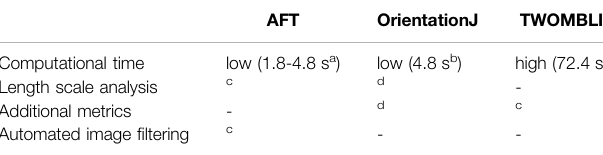
TABLE 1 | A comparison of the performance and characteristics of the three analysis